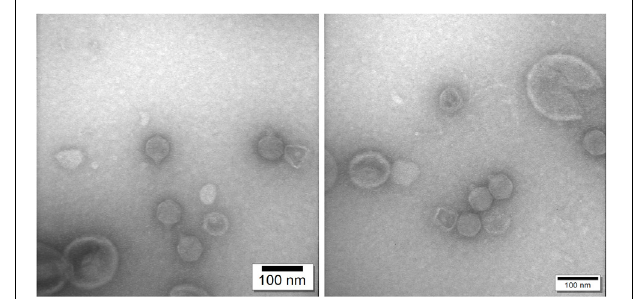
FIGURE 8 | Transmission electron microscopy confirms that phage φ 80-18 belongs to Podoviridae family of